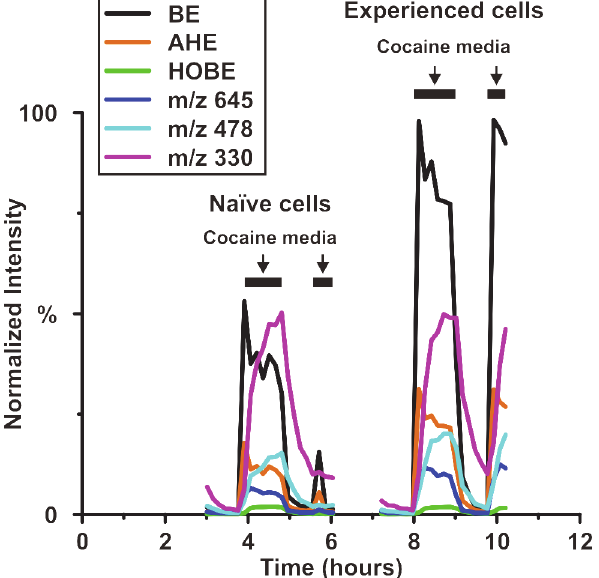
Fig 8. Additional metabolite time course data compared to benzoylecgonine (BE). Experimental conditions for each group of cells are shown above the graph with solid black lines indicating exposure to cocaine media. Anhydroecgonine (AHE) and hydroxybenzoylecgonine (HOBE), two additional metabolites of cocaine, provide examples of both variation between na ï ve and experienced cell groups in the case of AHE and consistency between these two groups in the case of HOBE. The increases in BE and AHE from na ï ve to experienced groups are statistically significant with respective p values of 5 . 7 x 10 – 4 and 1 . 12 x 10 – 3 . Three unidentified metabolites (m/z 645, m/z 478, and m/z 330) that contribute to the separation between media exposure groups are also shown. m/z 330 and m/z 478 show no statistical significance between na ï ve and experienced cell groups while the increase in m/z 645 is statistically significant ( p = 1 . 6 x 10 – 3 )